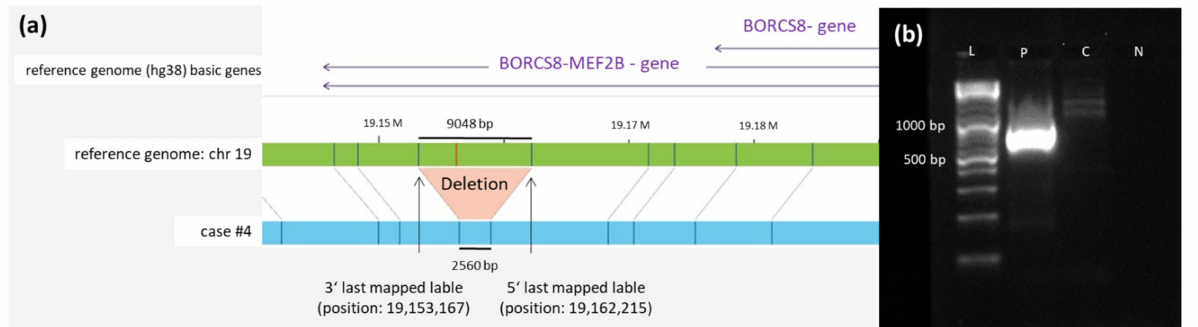
Figure 2. Deletion at chromosome 19. ( a ) Schematic representation of the newly identified deletion on chromosome 19 in case #4 detected by OGM. The first bar represents the reference genome (hg38) basic genes located at the depicted position ( BORCS8-MEF2B ). The second bar (green) shows the reference genome map of chromosome 19. The last bar (blue) represents the map of case #4. Vertical blue lines represent mapped labels, whereas red vertical lines represent missing labels in case #4 indicating the deletion. ( b ) Validation of the chromosome 19 deletion in case #4 via PCR. Deletion-spanning PCR was performed on genomic DNA of case #4 using forward and reverse primers (see sequences given in Table S3), generating a product with the expected length of 792 bp. A healthy control-DNA and the negative control were both negative in the PCR. Abbreviations: C = control-DNA; chr = chromosome; hg38 = human genome project 28; L = length marker; N = negative control (H 2 O); P = sample from case #4 collected at diagnosis; RNF = ring finger